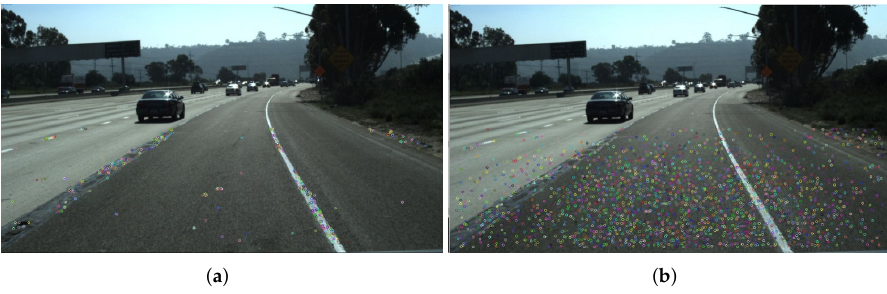
Figure 2. The comparison of feature points extraction between using ( a ) Opencv and ( b ) our